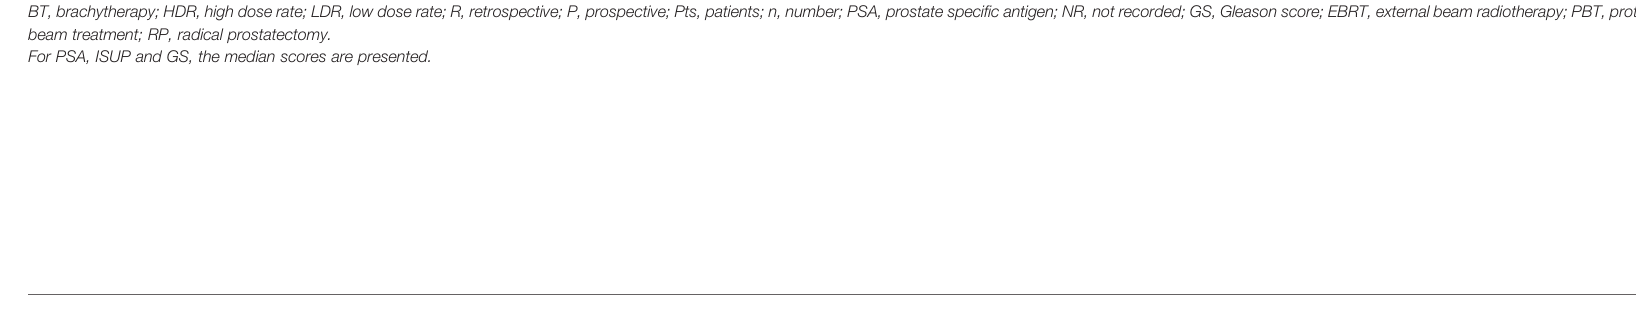
TABLE 5 | Pre-salvage therapy disease and treatment characteristics for EBRT